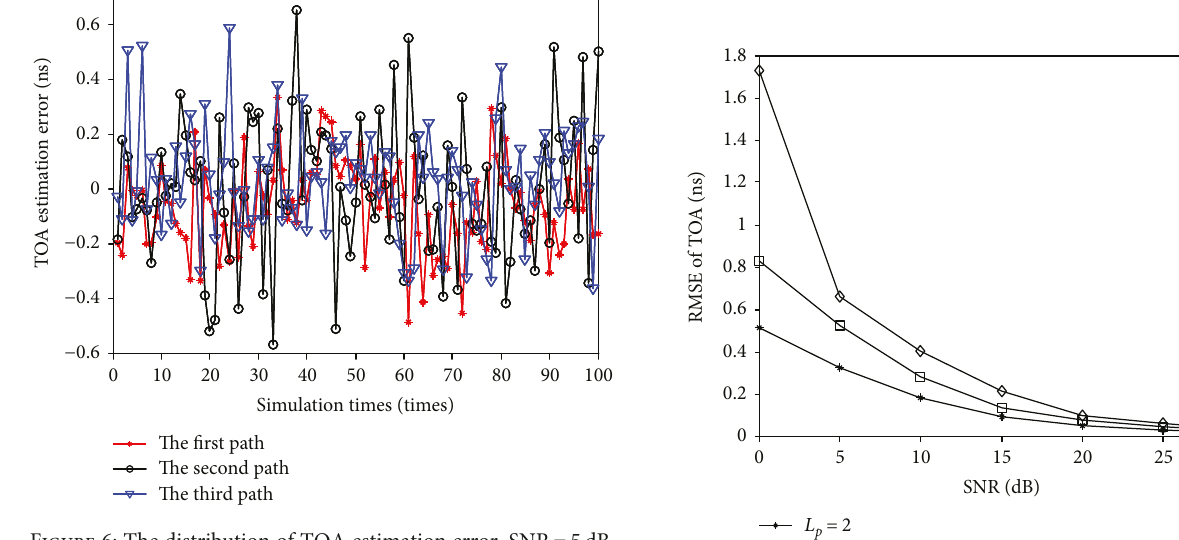
Figure 7: The distribution of DOA estimation error, SNR=5 dB.